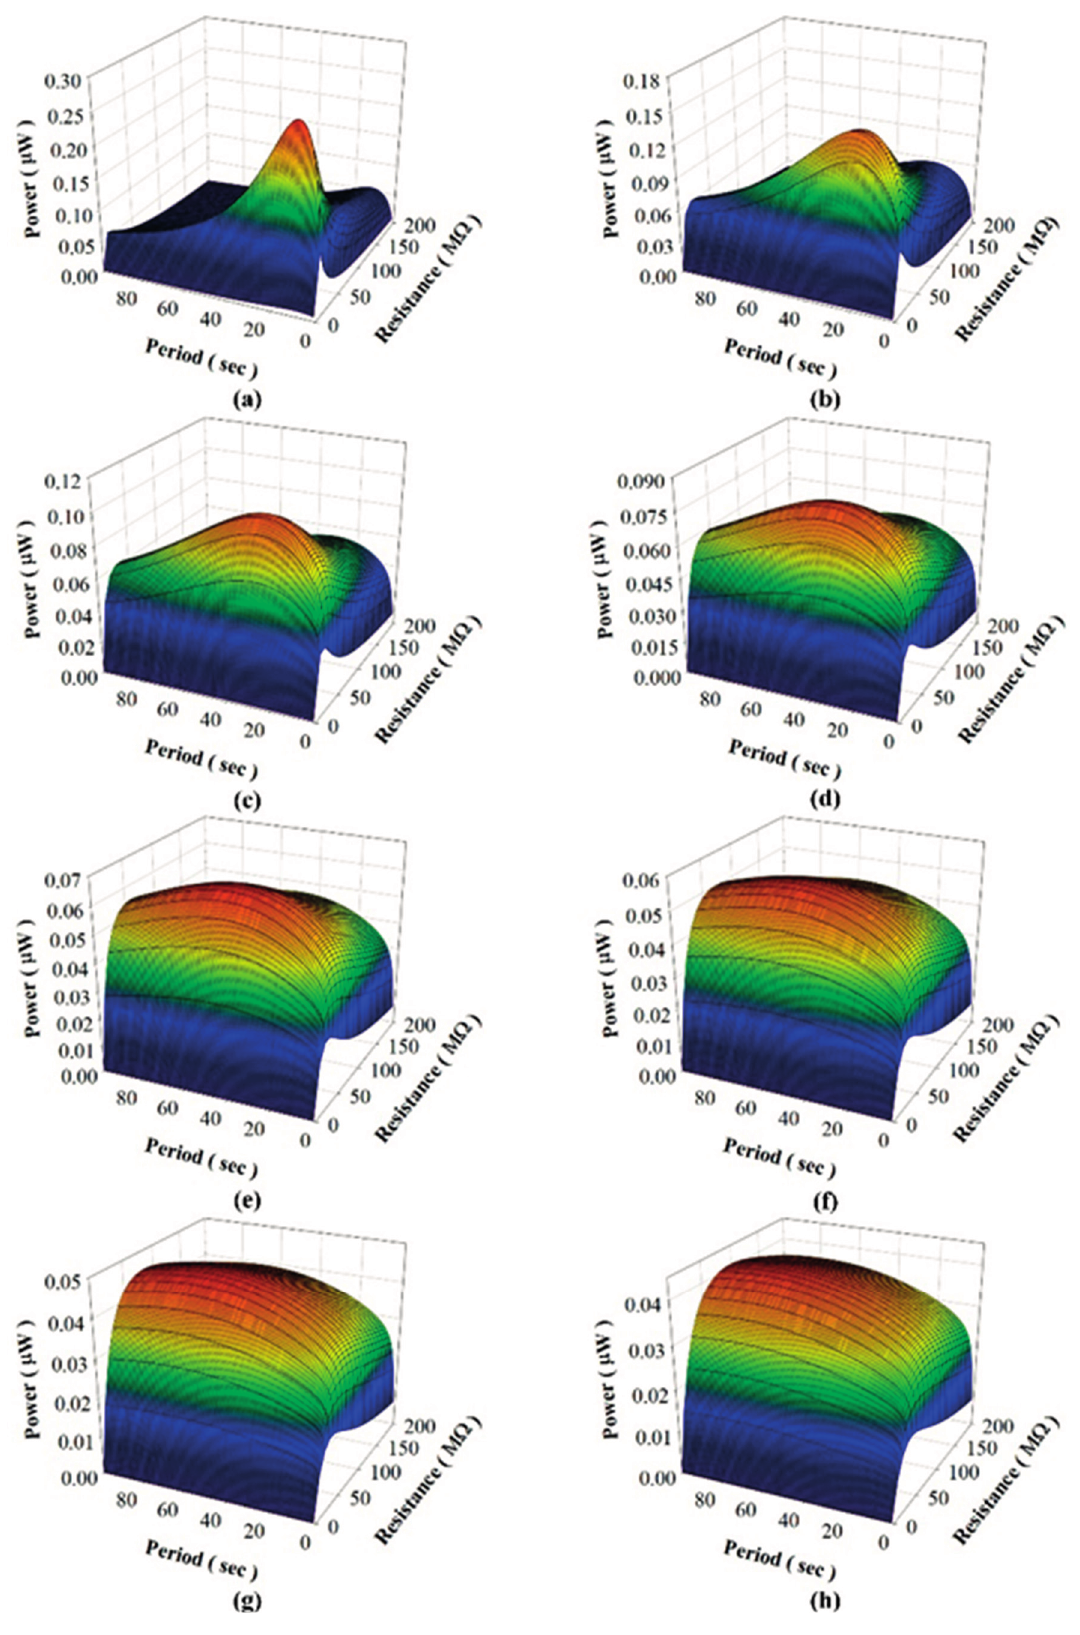
Figure 10. Relationships between the harvested power, load resistance and period when using PZT cells with thicknesses of 50 μ m ( a ); 100 μ m ( b ); 150 μ m ( c ); 200 μ m ( d ); 250 μ m ( e ); 300 μ m ( f ); 350 μ m ( g ); and 400 μ m ( h